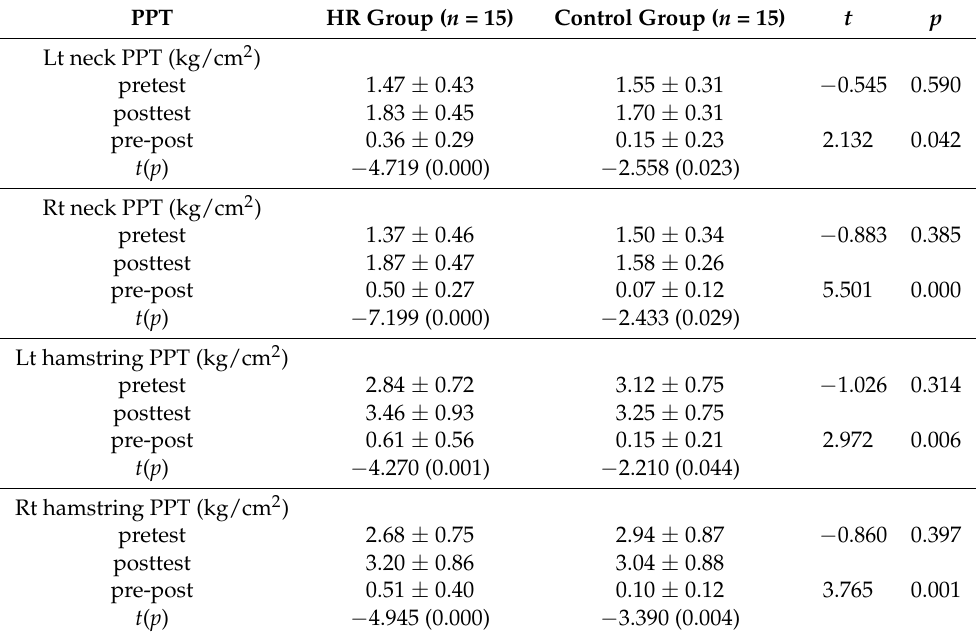
Table 3. Comparison of pain pressure threshold (N =